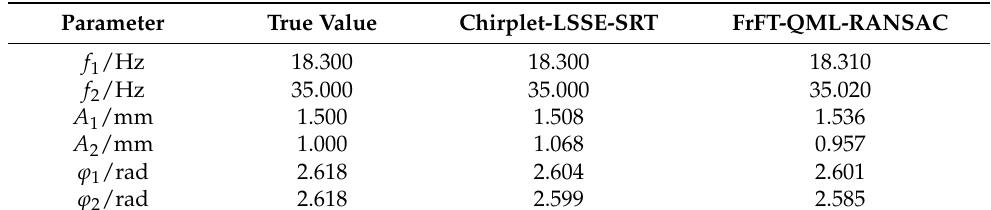
Table 3. Estimate of high-frequency vibration parameters.